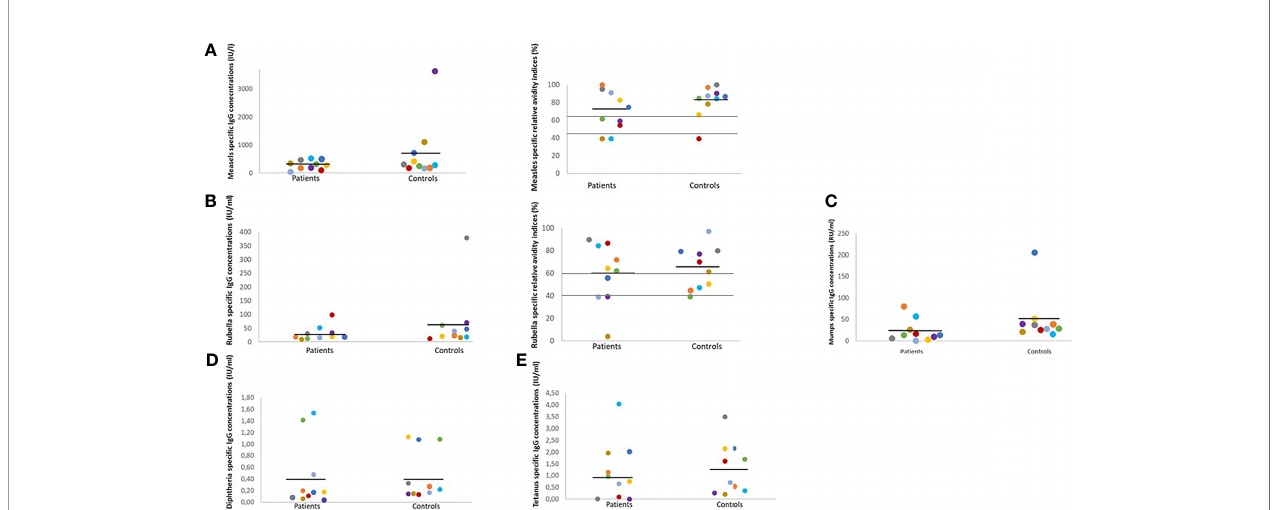
FIGURE 2 | Antigen-speci fi c IgG concentrations and RAI in sex- and age-matched patients and controls. RAI, relative avidity indices, IU, international units; RU, relative units; U, units; ml, milliliter; Each color indicates one matched pair of patient and control: pair 1 grey, pair 2 lilac, pair 3 yellow, pair 4 green, pair 5 orange, pair 6 red, pair 7 light blue, pair 8 dark blue, pair 9 brown, pair 10 violet. Black line indicates mean; grey lines indicate upper and lower RAI reference values. In age- and sex-matched patient/control pairs lower IgG concentrations and RAI rates were detected in PA patients. (A) Positive measles-speci fi c IgG concentrations values ≥ 275 IU/l, negative IgG concentrations ≤ 200 IU/l. High RAI ≥ 60.0%, intermediate RAI 40-59.9%, low RAI ≤ 39.9%. (B) Positive rubella-speci fi c IgG concentrations values ≥ 11 IU/ml, negative rubella-speci fi c IgG concentrations ≤ 8 IU/ml. High RAI ≥ 60.0%, intermediate RAI 40-59.9%, low RAI ≤ 39.9%. (C) Positive mumps-speci fi c IgG concentrations values ≥ 22 RU/ml, negative IgG concentrations ≤ 16 RU/l. (D) Positive diphtheria-speci fi c IgG concentrations values ≥ 0.1 IU/ml, negative diphtheria-speci fi c IgG concentrations ≤ 0.01 IU/ml. (E) Positive tetanus-speci fi c IgG concentrations values ≥ 0.5 IU/ml, negative tetanus-speci fi c IgG concentrations ≤